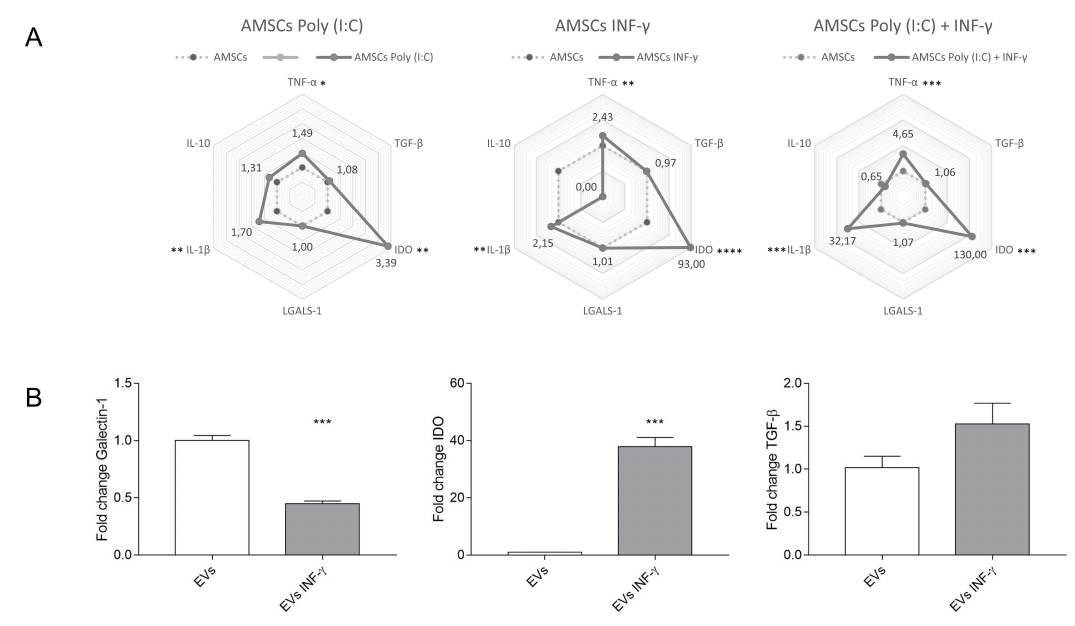
Figure 6. Gene expression analysis of selected transcripts in unlicensed and licensed AMSCs. ( A ) Radial plot demonstrating the differences in overall transcripts between unlicensed AMSCs, as well as AMSCs licensed with 1 µ g/mL of Poly (I:C), AMSCs licensed with 50 ng/mL INF- γ and AMSCs licensed with both 50 ng/mL of INF- γ and 1 µ g/mL of Poly (I:C). Solid vertices represent the mean fold change of individual transcripts. Median Ct value of unlicensed AMSCs was used as a reference. Results are presented as the mean of three independent experiments; ( B ) Expression of Galectin-1, IDO, IL-10 and TGF- β transcripts in EVs isolated from unlicensed and INF- γ licensed AMSCs. To analyze IDO expression in EVs, the CT value of EVs obtained from unlicensed AMSCs was arbitrarily defined as 40. *** p <